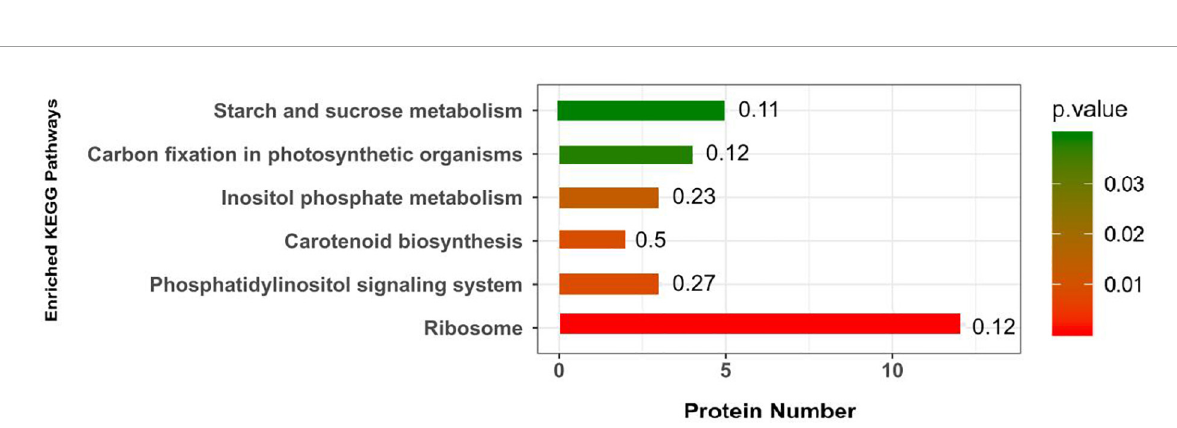
Frontiers in Plant